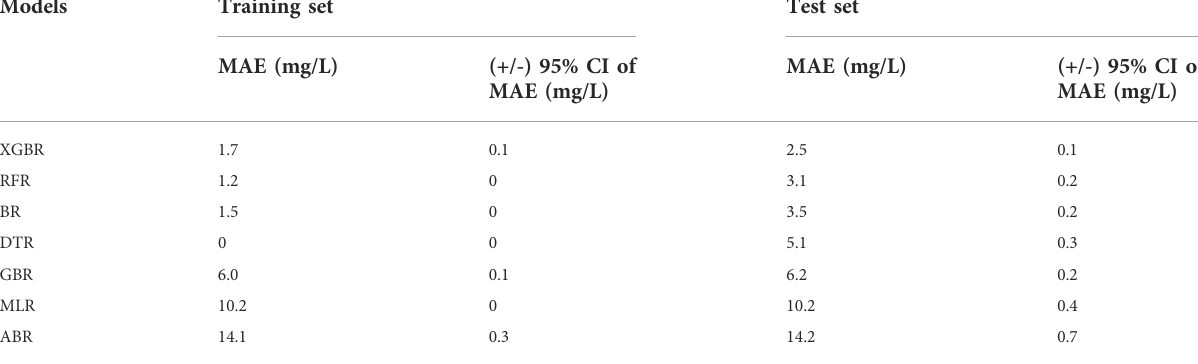
TABLE 5 The mean absolute error (MAE) at 95% con fi dence interval (CI) for the prediction of the value of C ss of VPA in the derivation cohort for the XGBoost and other regression models.